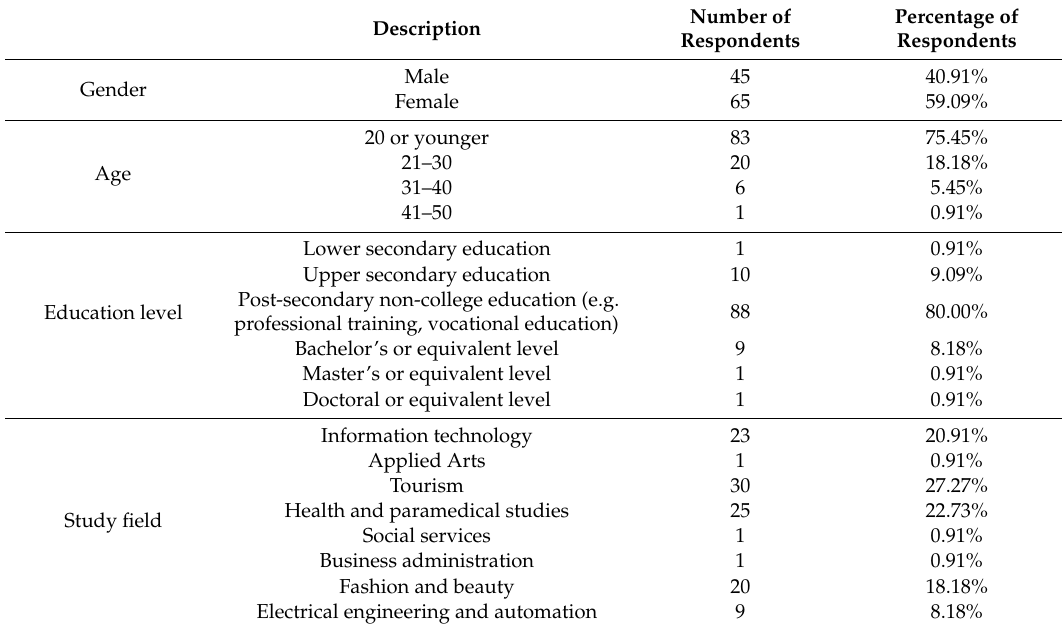
Table 2. Survey demographics and descriptive statistics.